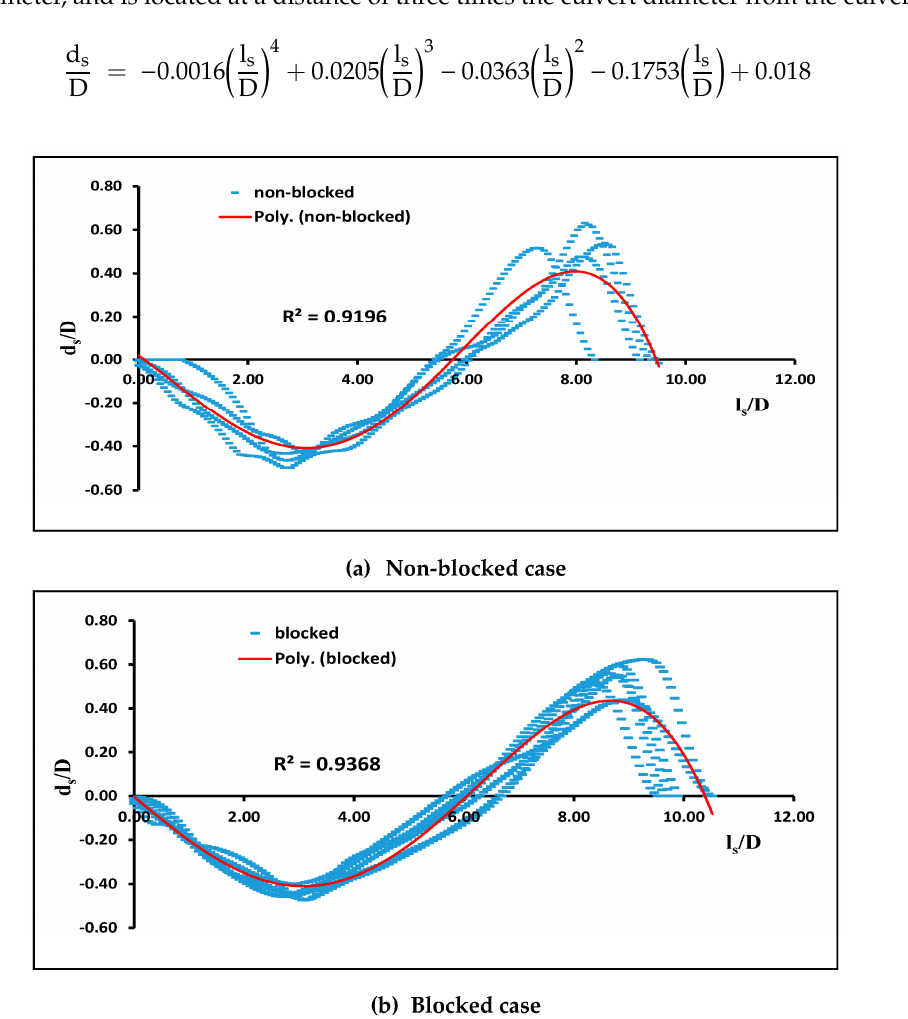
Figure 13. Scour profile along centerline for ( a ) non-blocked case ( b ) blocked case.